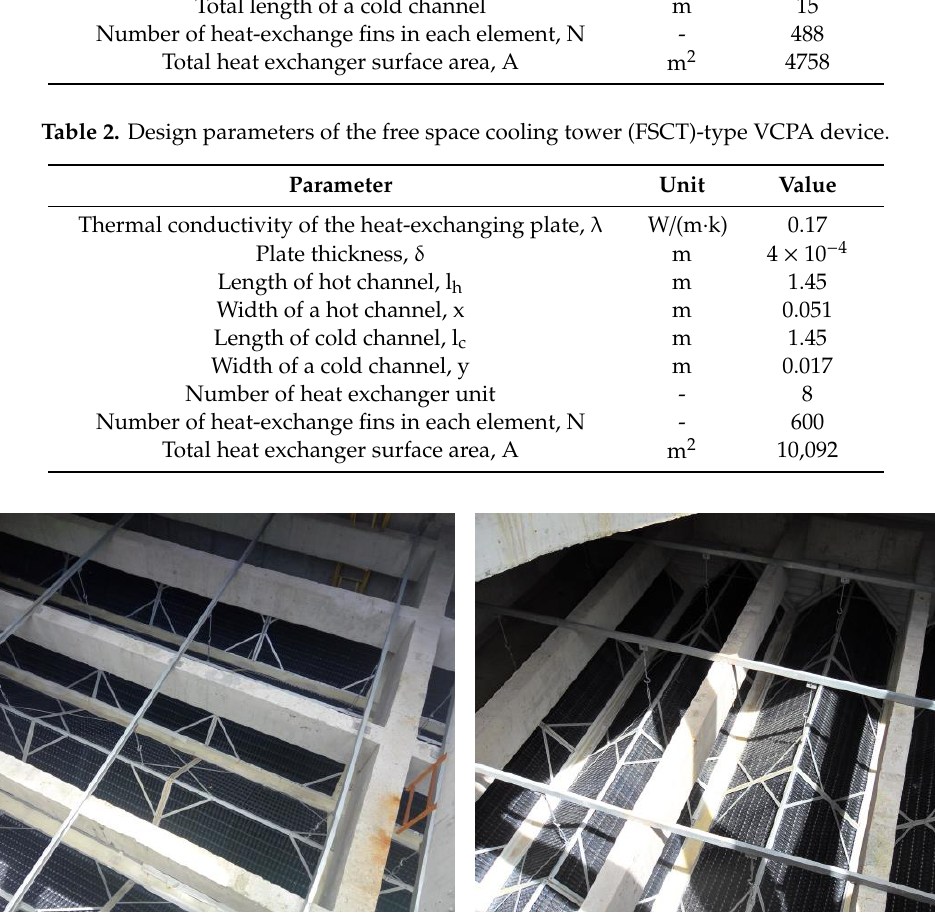
Figure 9. The spatial layout of vapor-condensing plume abatement (VCPA) devices in the cooling tower.